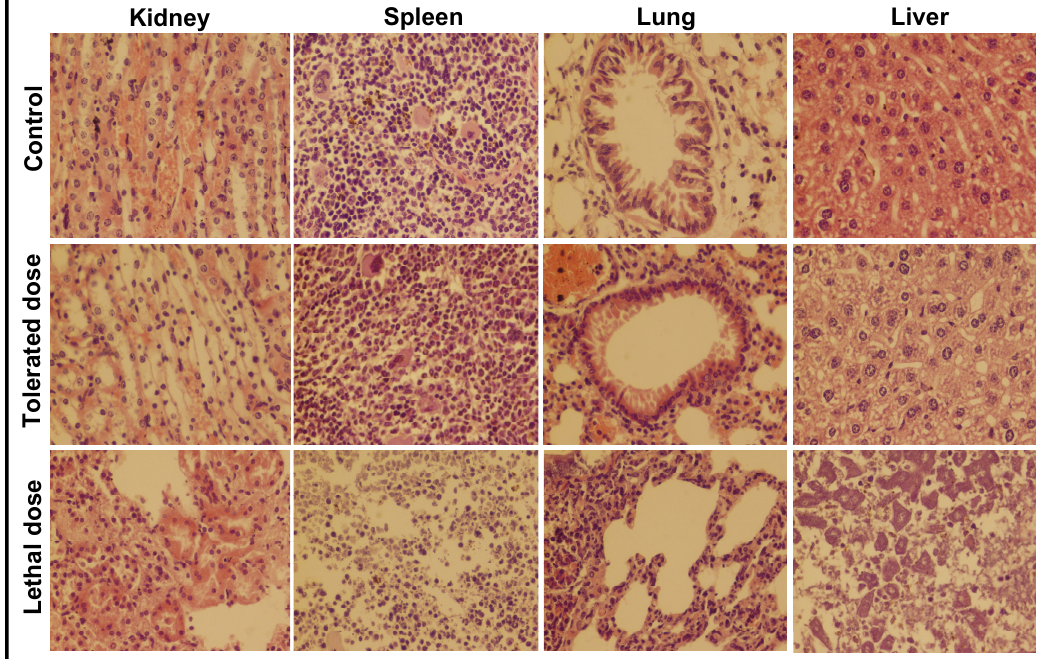
Figure 7. The histopathological examination of the kidney, spleen, lung and liver of mice after injecting a low and a high dose of S. aureus inoculums for 14 days; (tolerated dose = 3 × 10 7 CFUs; lethal dose = 4 × 10 7 CFUs).